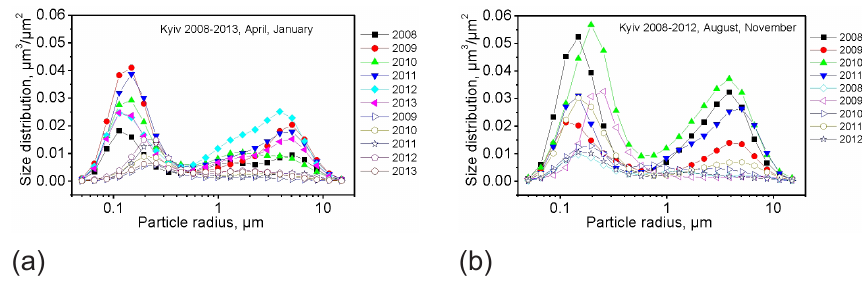
Figure 7. Monthly mean aerosol particle volume size distribution in the 2008–2013 period for the months that describe (a) maximum AOT (440nm) in spring (April, filled symbols) and minimum in winter (January, open symbols); (b) maximum AOT (440nm) in late summer (August, filled symbols) and minimum in autumn (November, open symbols). The Kyiv AERONET site level 2.0